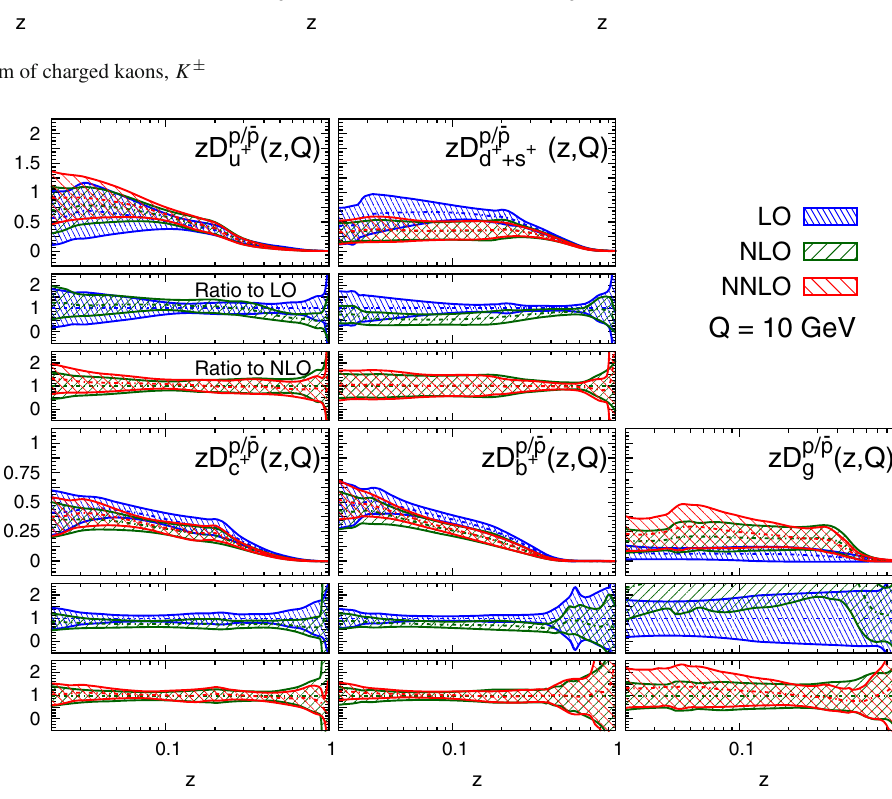
Fig. 10 Same as Fig. 9 but for the sum of charged kaons, K ±